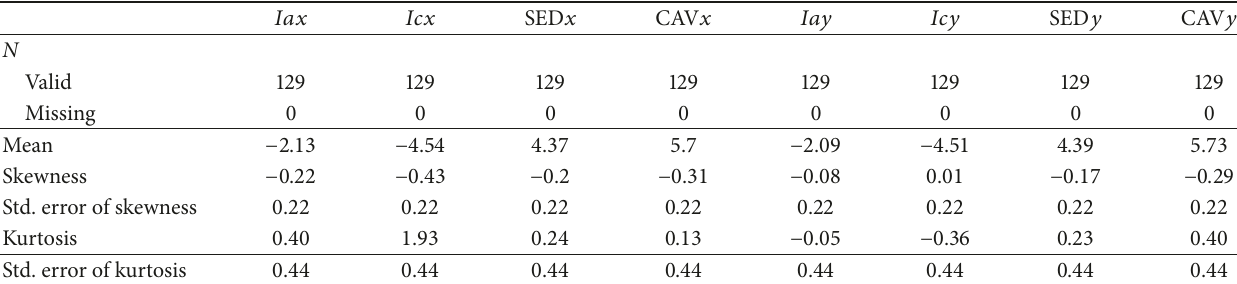
Table 3: Transformed data.